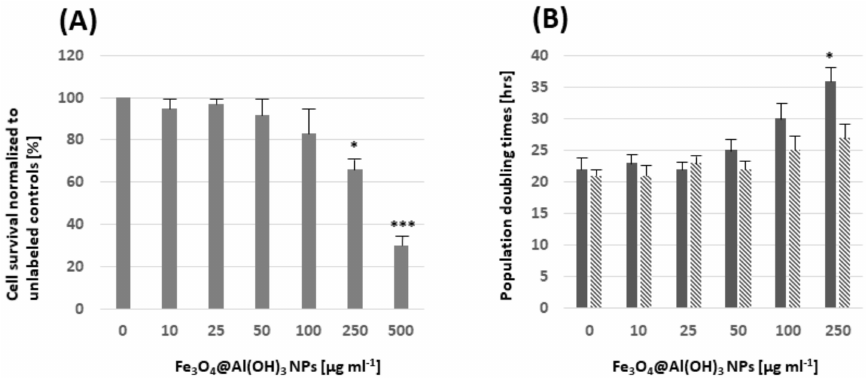
Figure 11. ( A ) Cell viability relative to the unlabeled control MSC was determined 12 h after exposure to Fe 3 O 4 @Al(OH) 3 NPspost-labeling: Asignificantreductioninthecellsurvivalwasseenforconcentrations > 100 µ g NP mL − 1 . ( B ) Population doubling times (PDT) were determined after exposure of MSC to NPs for 12 h and subsequent incubation in NP-free medium for two days (solid bares) and six days (striped bares). Significant differences with respect to PDTs were only seen for concentrations of 250 µ g NP mL − 1 at two days after the removal of NPs from the medium. Three replicates were measured per